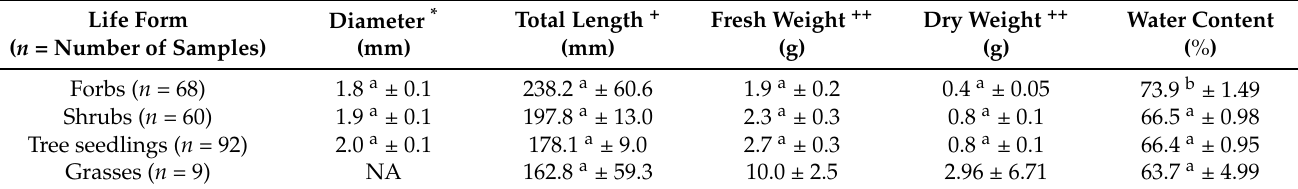
Table 1. Characteristics of forage plant parts utilized by large herbivores. The numbers are means ± 1 standard error. The letters in superscript indicate significantly different groups based on Tukey Honest Significant Differences ( α =